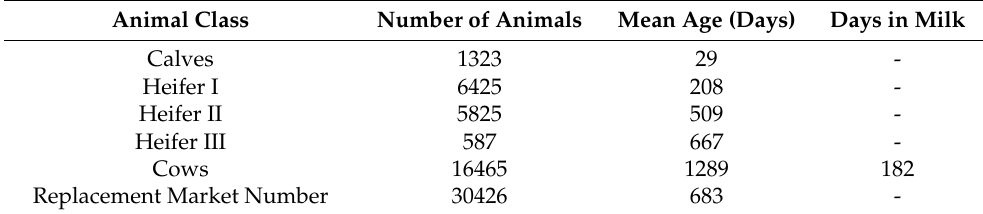
Table 1. Example initialization and replacement herd